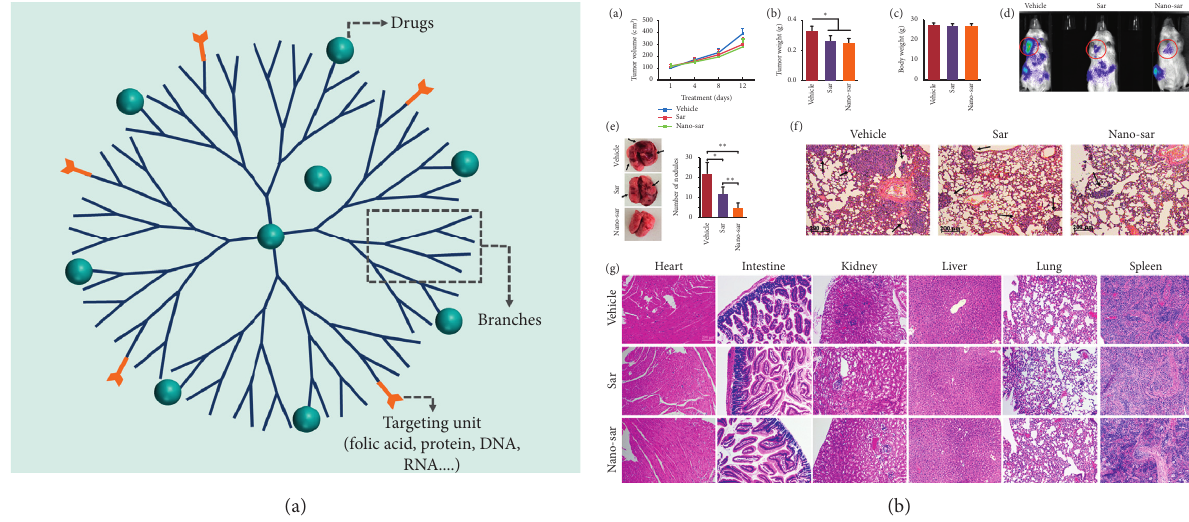
Figure 3: (a) Multifunctional dendritic carrier with dual functions of diagnosis and treatment. (b) Nano-sar effectively suppressed invasion and metastasis of head and neck squamous cell carcinoma without systematic toxicities, Copyright 2018, Springer Nature